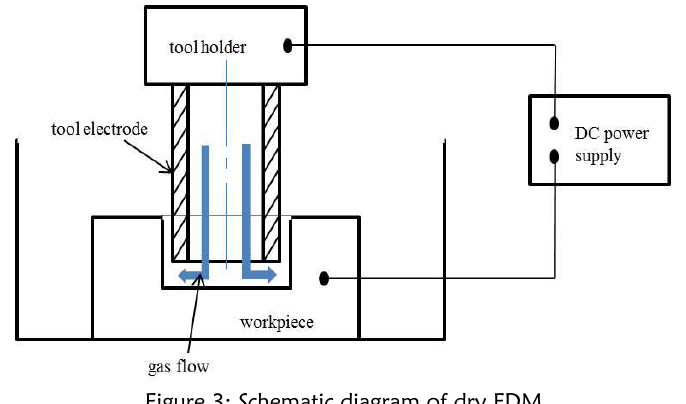
Figure 3: Schematic diagram of dry